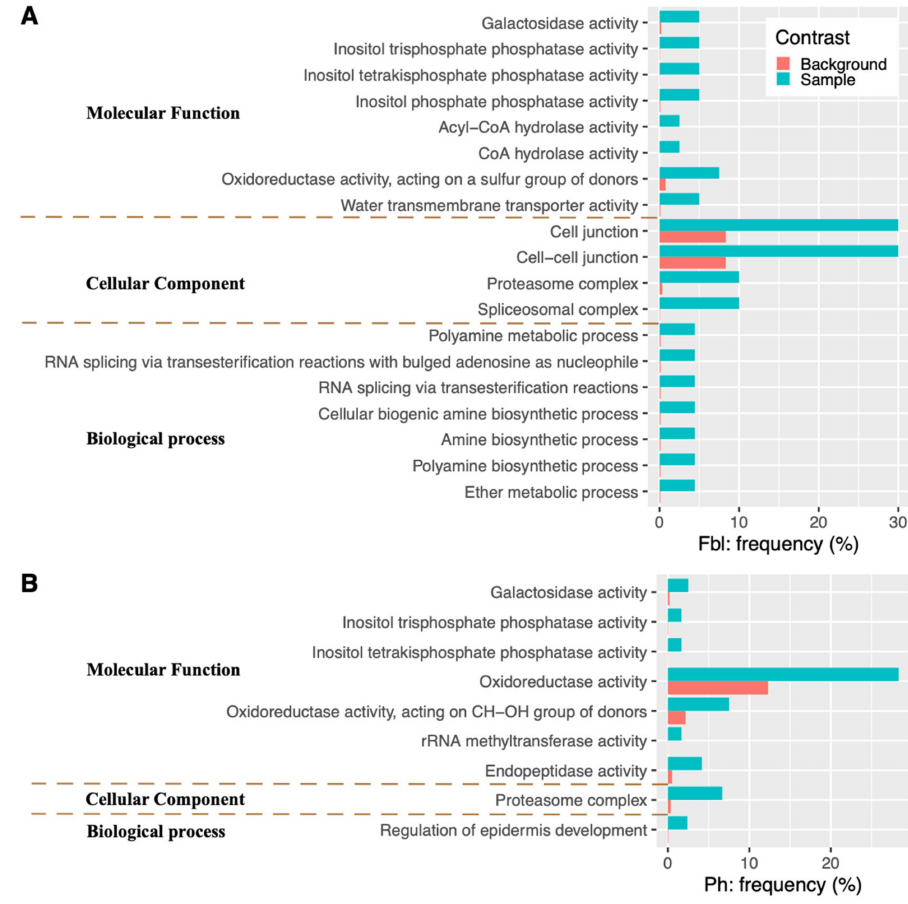
Figure 4. GO terms of candidate genes significantly enriched for Fbl ( A ) and Ph ( B ). The shown gene frequencies for each GO term are either among the candidate genes (blue) or among the background gene database